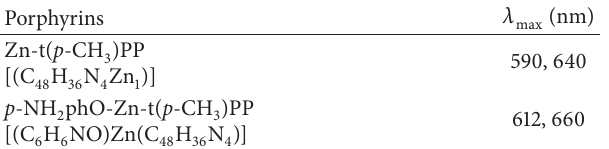
Table 6: Fluorescence spectral data of axially ligated compound of X-Zn-t( p -CH 3 )PP (X = different phenols as axial ligands) in methanol solvent using excitation at ∼ 550 nm.